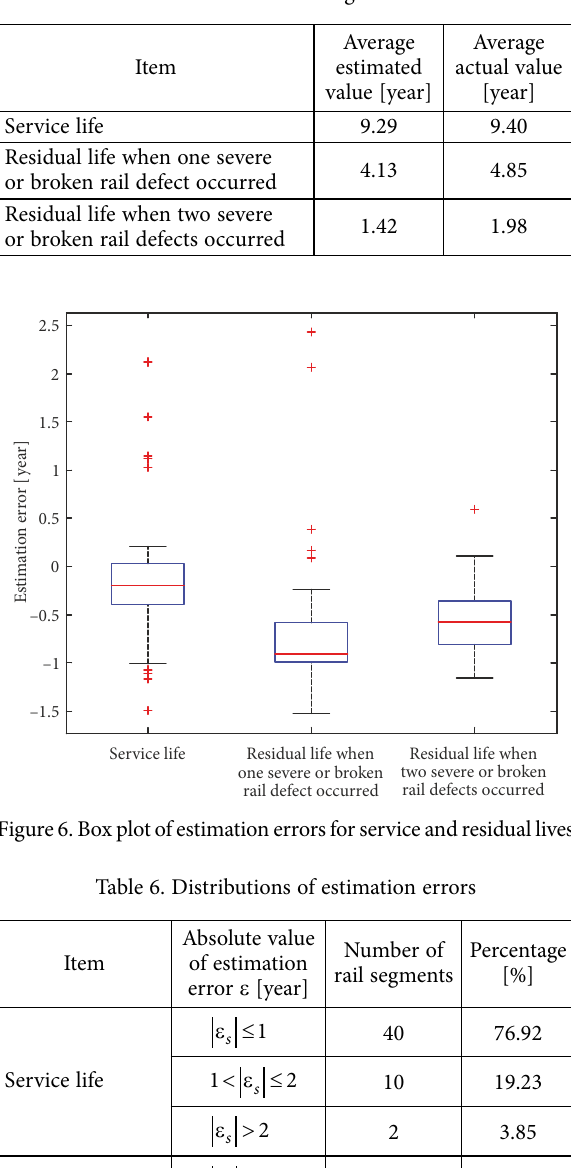
Table 5. Comparison of the average estimated and actual values